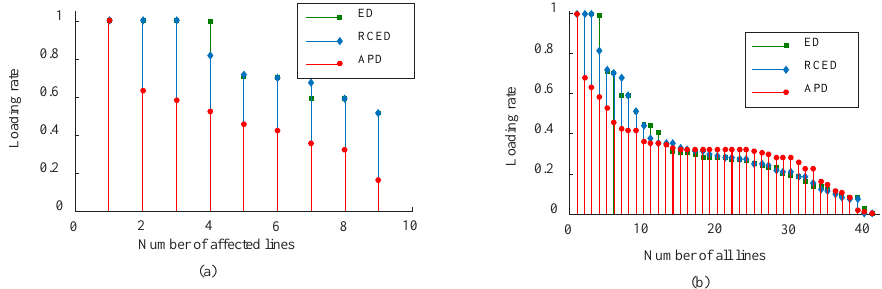
Figure 2. Loading rates for ( a ) lines affected by extreme weather and ( b ) all lines ranked from highest to lowest.